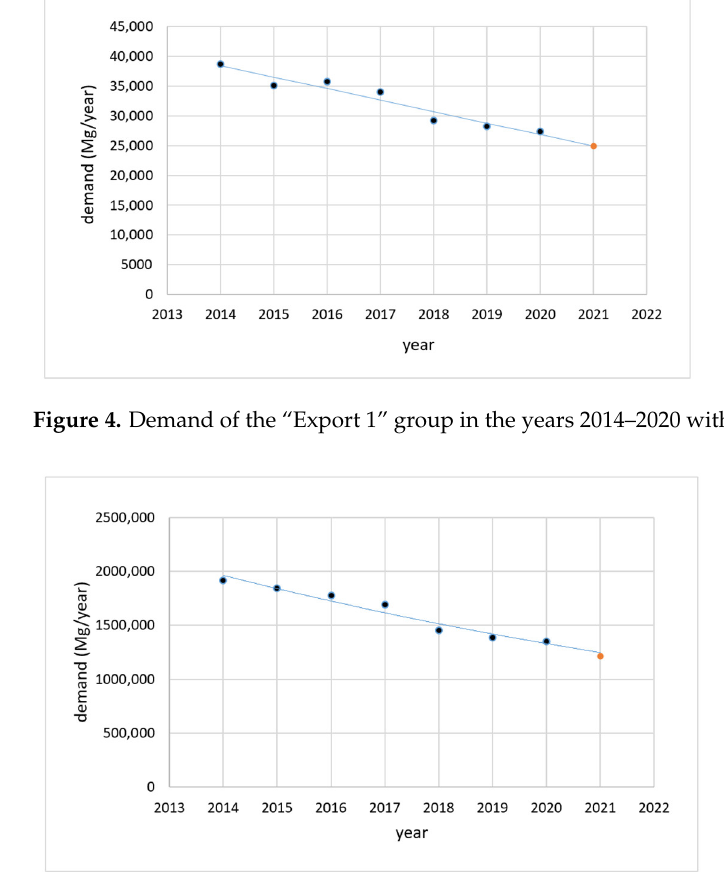
Figure 3. Demand of the “Indv. consumers 1” group in the years 2010–2020 with the forecast for 2021.